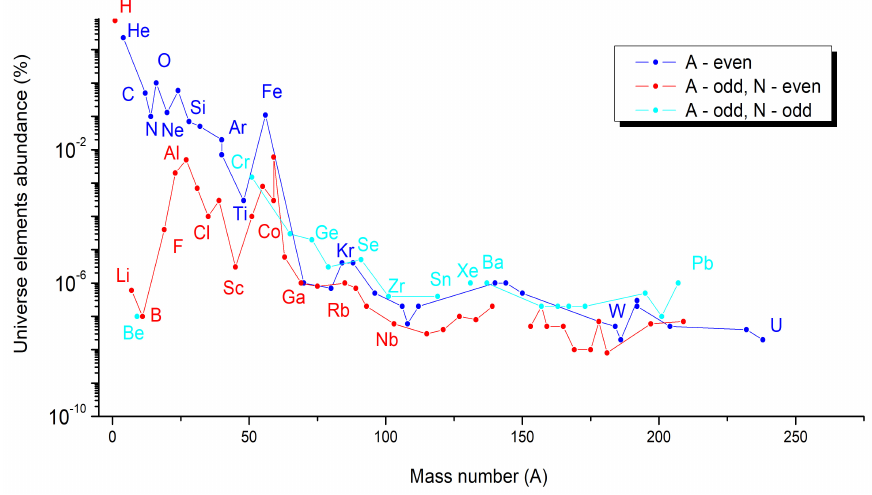
Figure 5. Universe-abundant elements as a function of their mass number (A) [49].